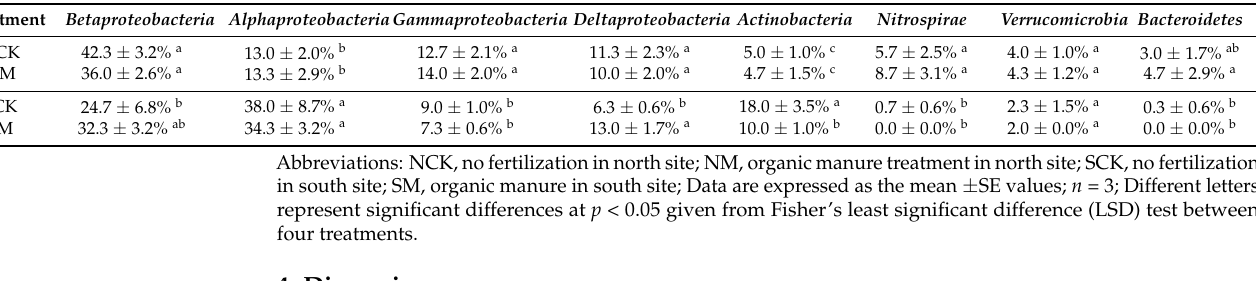
Figure 3. The relative abundance of ureolytic microbes across samples at phylum/class level. Table 3. Relative abundance of abundant (>1%) ureolytic microbes at phylum